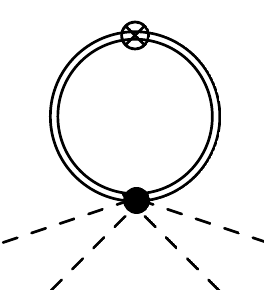
Figure 14 . Tadpole diagram contributing to the running of the quartic scalar coupling within the standard ASQG